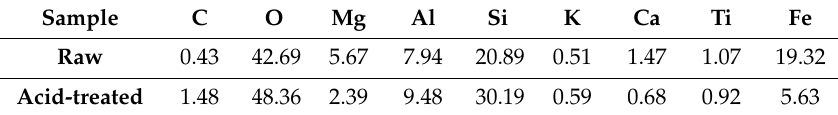
Table 1. Elemental composition of saponite samples (values are expressed in mass%).